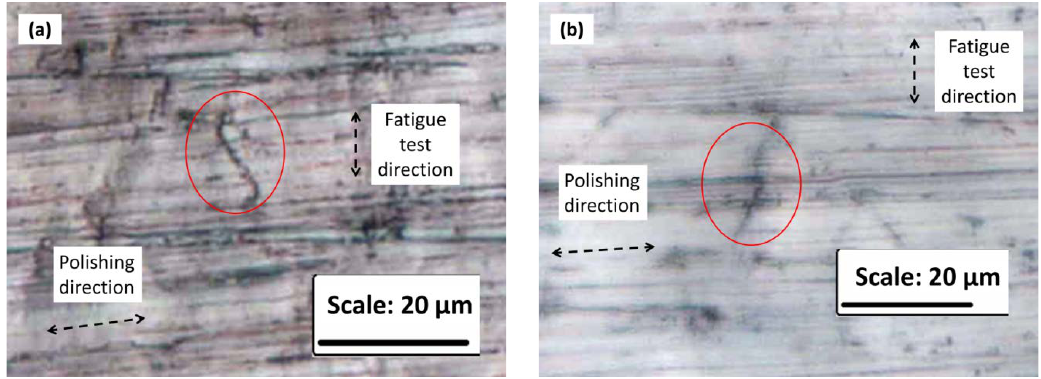
Figure 3. Crack initiation of ( a ) the fine grain sample, and ( b ) the coarse grain sample.